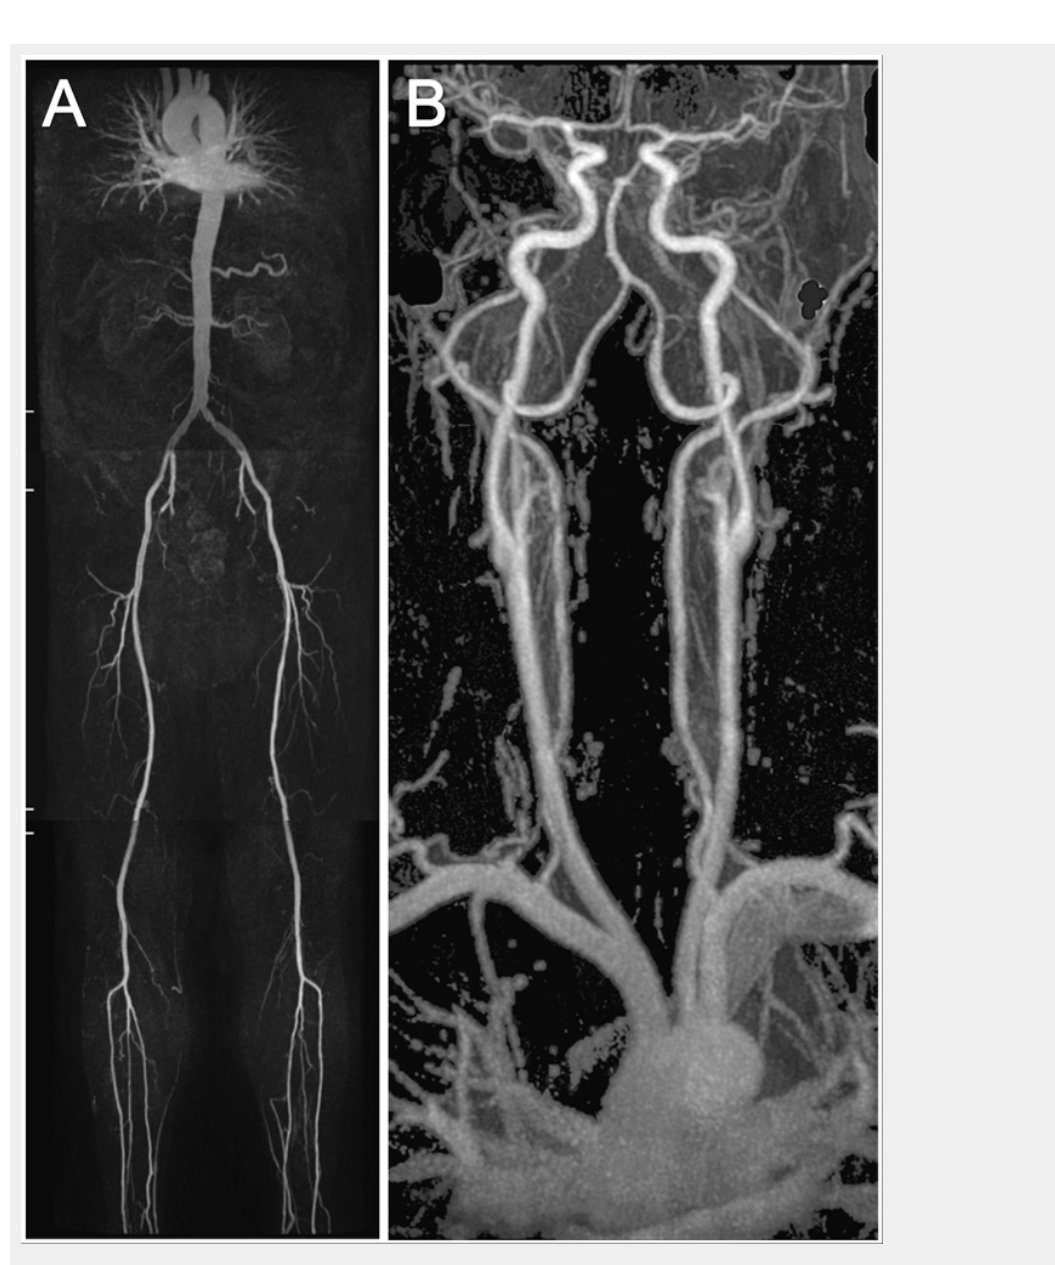
An example showing the MR whole body angiography. The first part of the MR whole body angiography included thoracic/renal-, pelvis/thigh-, knee/calf-stations (A). The second part included the thoracic/carotid-station